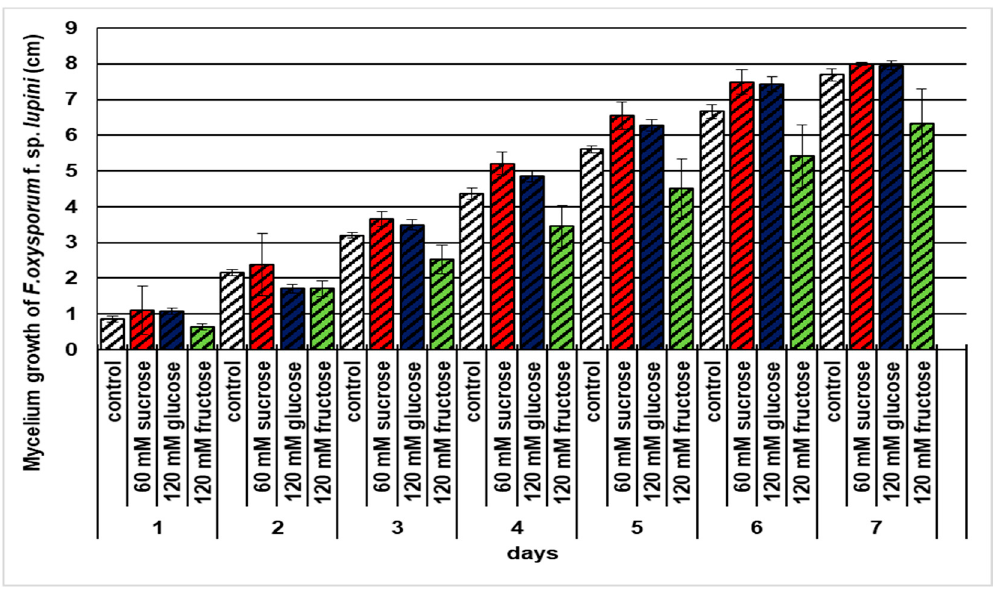
Figure 1. Effects of sucrose, glucose, and fructose on the mycelium growth of Fusarium oxysporum f. sp. lupini . A summary of the statistical significance of differences between the average values of each pair at p < 0.05 can be found in the Supplementary Files (Table S1).